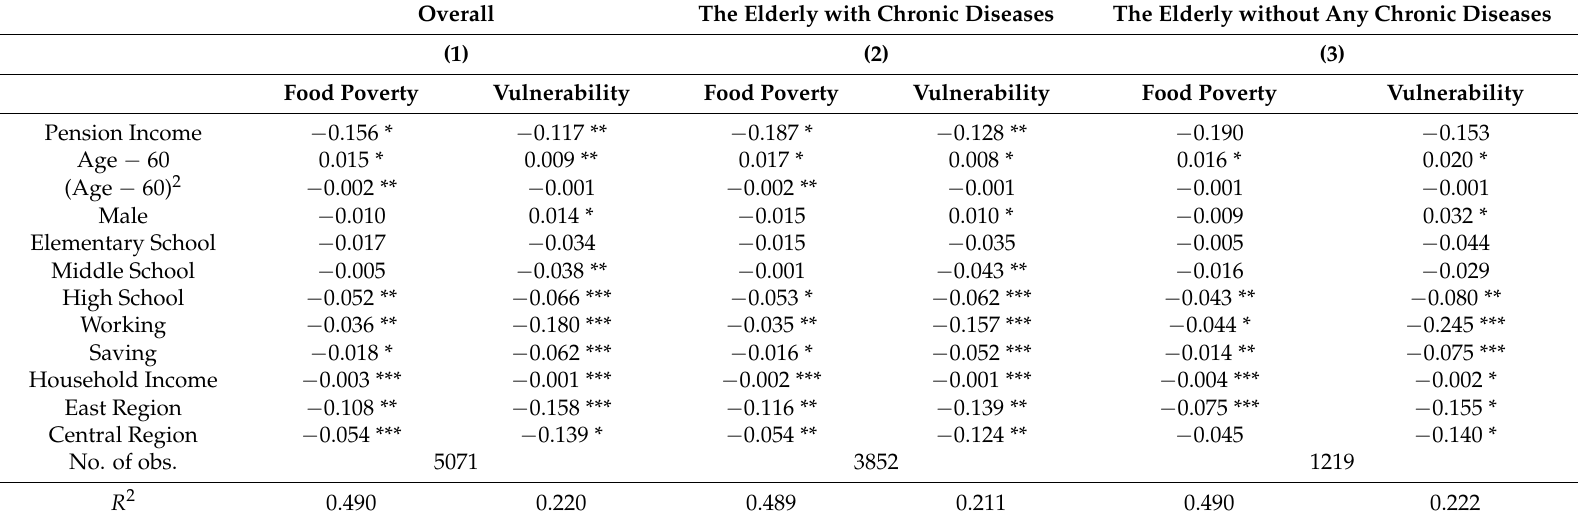
Table A3. Effects of pension income on food poverty and vulnerability of the elderly aged between 52 and 68. Overall The Elderly with Chronic Diseases The Elderly without Any Chronic Diseases Food Poverty Vulnerability Food Poverty Vulnerability Food Poverty